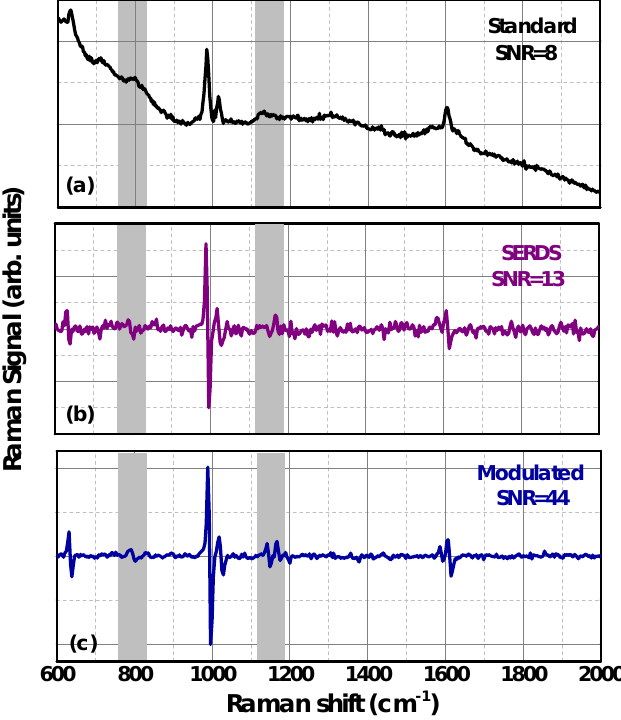
Figure 4. ( a ) Standard Raman spectrum of a polystyrene bead (2 µ m sized) in a solution 10 − 7 M of NIR-dye; ( b ) the shifted excitation Raman difference spectroscopy